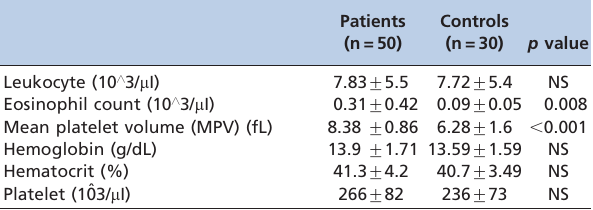
Table 2 - A comparison of the whole blood count features of the patients and controls.